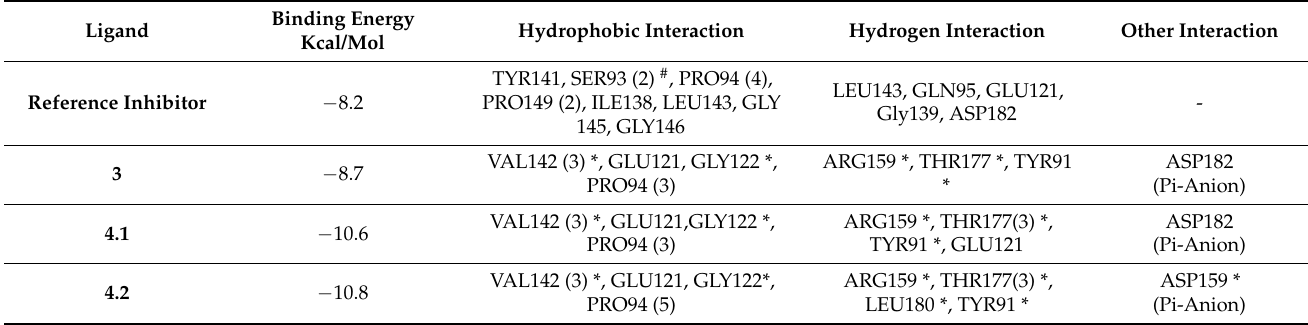
Table 2. The results of the docking studies of 3, 4.1 and 4.2 and the native inhibitor to the active site of P. aeruginosa